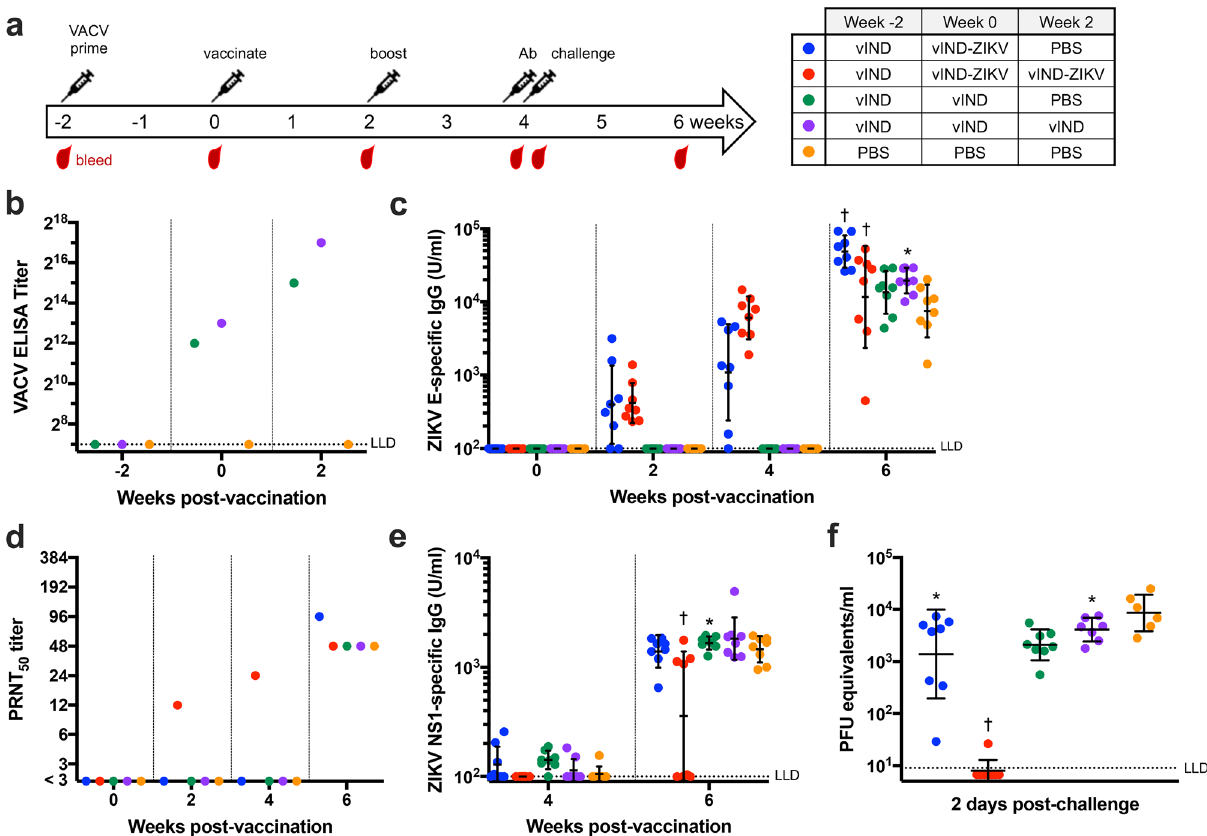
Figure 6. Two vaccinations with vIND-ZIKV are required to protect mice against ZIKV in mice with prior vector immunity. ( a ) Schematic of vaccination/challenge schedule and timing of blood collection in VACV- primed mice. Six-week-old immunocompetent C57BL/6 mice (n = 8) were vaccinated intramuscularly with PBS or 10 7 PFU vIND 2 weeks prior to first vaccination. Mice were then vaccinated with PBS or 10 7 PFU vIND or vIND-ZIKV (D4W) at weeks 0 and 2. Mice were challenged 2 weeks post-boost with 10 4 PFU ZIKV strain PRVABC59 intraperitoneally, 1 day after being administered 2 mg anti-IFNAR1 antibody intraperitoneally. ( b ) Anti-vector (VACV) antibodies were measured by ELISA in pooled serum collected at weeks − 2, 0, and 2. ( c ) ZIKV E-specific IgG titers were measured by ELISA at weeks 0, 2, 4 (1 day prior to challenge), and 6. ( d ) PRNTs were performed in twofold dilutions on pooled serum collected at the indicated time points. ( e ) ZIKV NS1-specific IgG titers were measured by ELISA at weeks 4 (1 day prior to challenge) and 6. ( f ) Viremia was measured in serum collected 2 days after ZIKV challenge by qRT-PCR. Asterisks represent statistical significance (*p < 0.05, † p < 0.005) by two-way repeated measures ANOVA ( c , e ) or unpaired t tests ( f ) compared to PBS-vaccinated control group. Horizonal lines represent geometric mean and error bars represent SD. LLD lower limit of